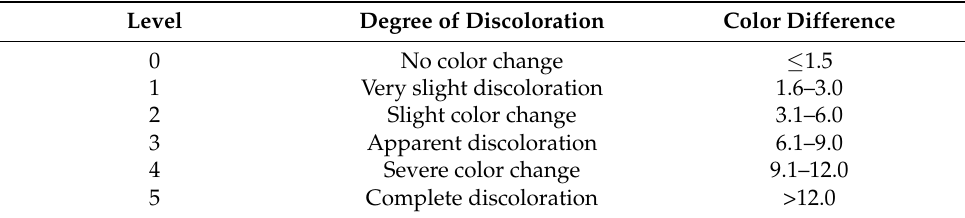
Table 3. Color change values corresponding to the level of discoloration. Level Degree of Discoloration Color Difference 0 No color